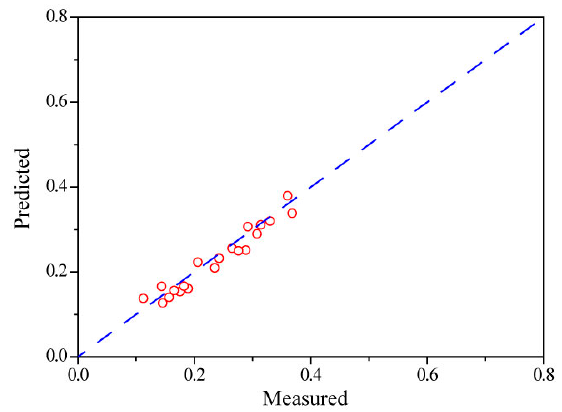
Figure 17. Comparison between measured minimum void ratio and predicted minimum void ratios using Equations (14) and (15).